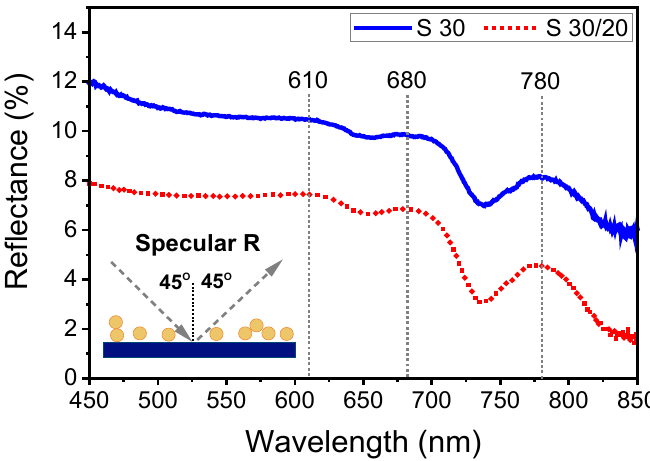
Figure 7. Optical reflectance spectra for sample S30 (solid blue curve) and S30 / 20 (red dotted curve). The incidence angle was 45°.